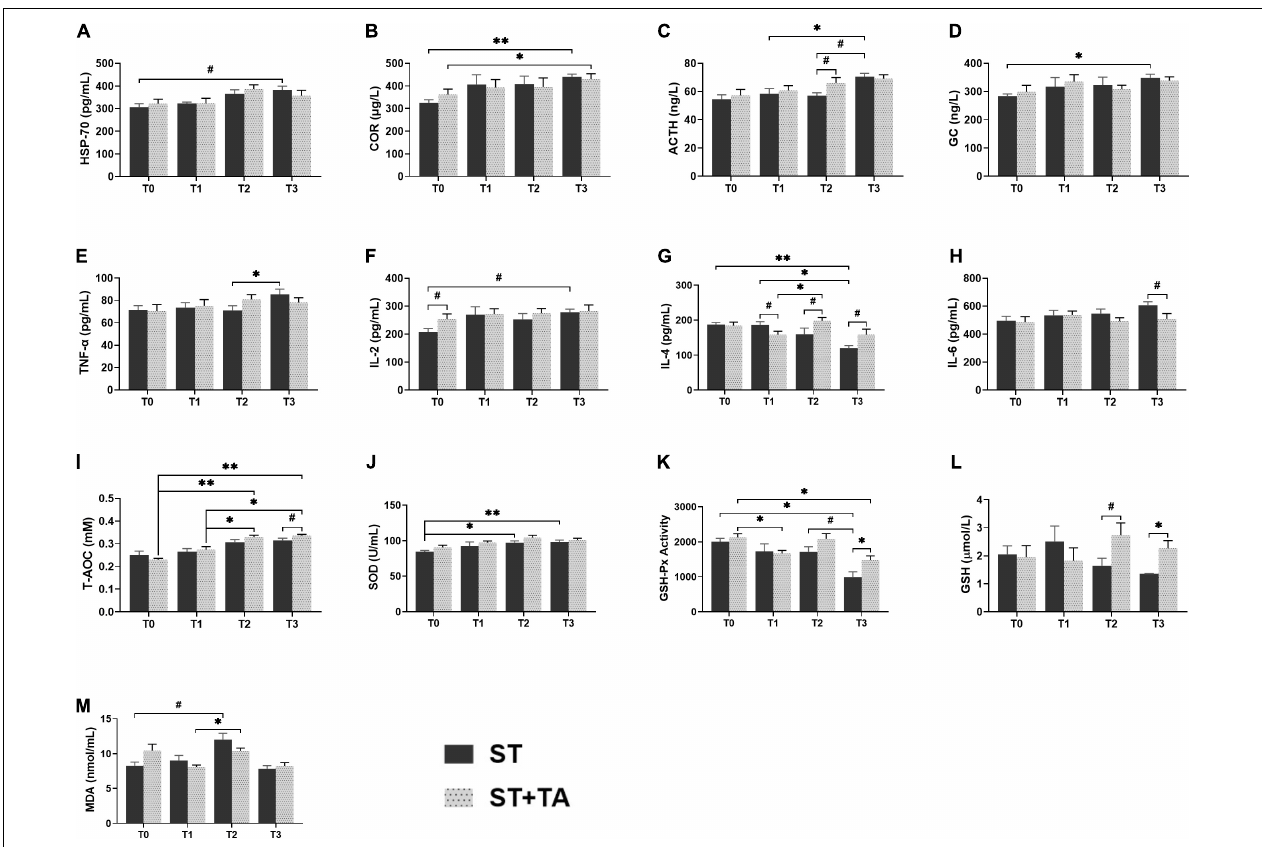
FIGURE 3 | Effect of TA on HSP-70 (A) , hormone (B–D) , inflammation (E–H) , and anti-oxidant (I–M) in dogs. Data are presented as mean ± SE ( n = 6 or 7). ∗ p < 0.05 and ∗∗ p < 0.01 represent the difference calculated by Student’s t -test between the ST and ST + TA groups or the difference of each group at T0–T3 calculated by RM-ANOVA; # p < 0.10 represents the difference in tendency calculated by Student’s t -test between the ST and ST + TA groups or the difference in tendency of each group at T0–T3 calculated by RM-ANOVA. T0, day 1 before transportation; T1, day 7 before transportation; T2, day 8 after transportation; T3, day 14 after transportation; HSP-70, heat stress protein 70; COR, cortisol; ACTH, adreno-cortico-tropic-hormone; GC, glucocorticoid; TNF- α , tumor necrosis factor- α ; IL-2, interleukin-2; IL-4, interleukin-4; IL-6, interleukin-6; T-AOC, total anti-oxidant capacity; SOD, superoxide dismutase; GSH-Px, glutathione peroxidase; GSH, glutathione; MDA,